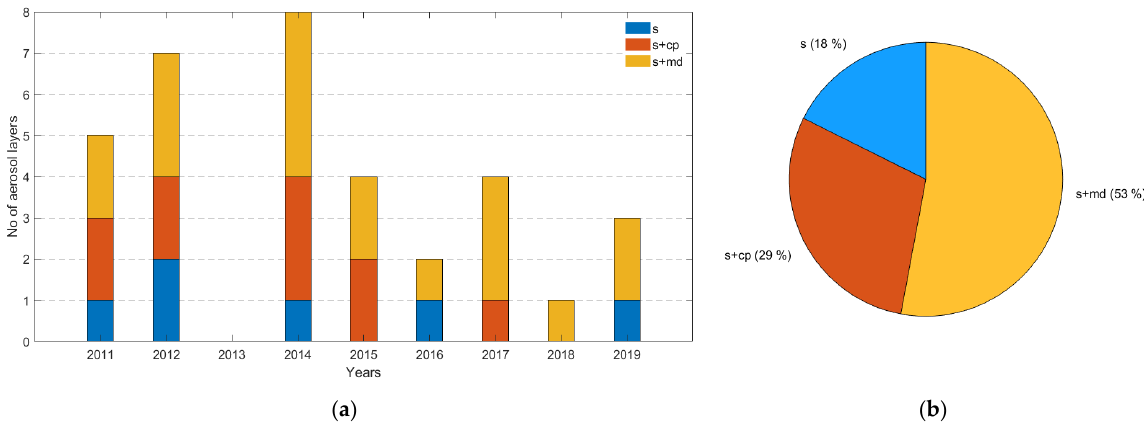
Figure 1. ( a ) Number of aerosol layers observed through the years 2011–2019 and sorted into one of the three different aerosol categories; ( b ) frequency distribution of the aerosol categories out of the 34 total aerosol layers. The 3 aerosol categories: smoke—“s” (blue), smoke and continental polluted “s+cp”—(red), and smoke and mixed dust—“s+md”